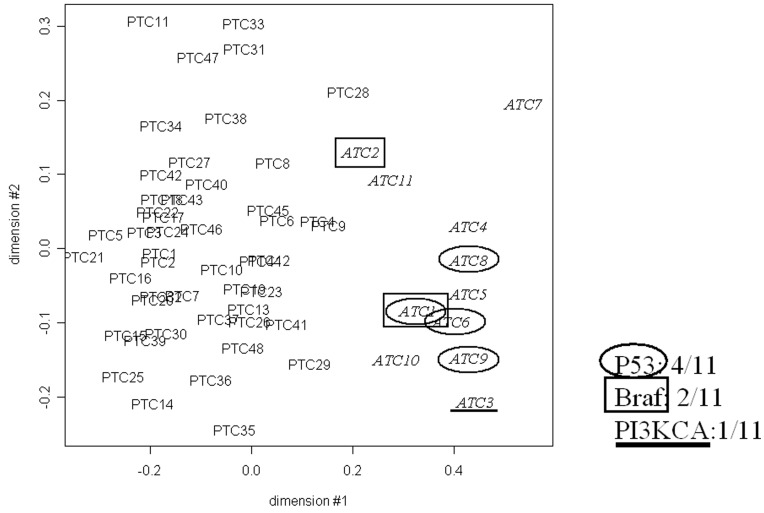
Multidimensional scaling (MDS) of the mRNA expression data from 11 ATC and 48 PTC (all the probes present on the array were considered).The ATC are labelled according to their mutation as depicted in the figure.